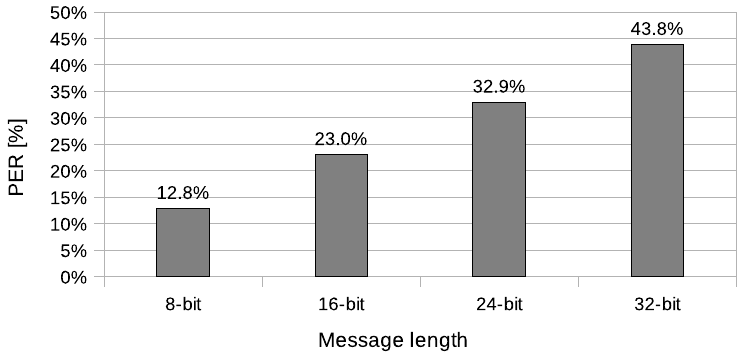
Figure 11. The packet error rate values (IEEE 802.11n,